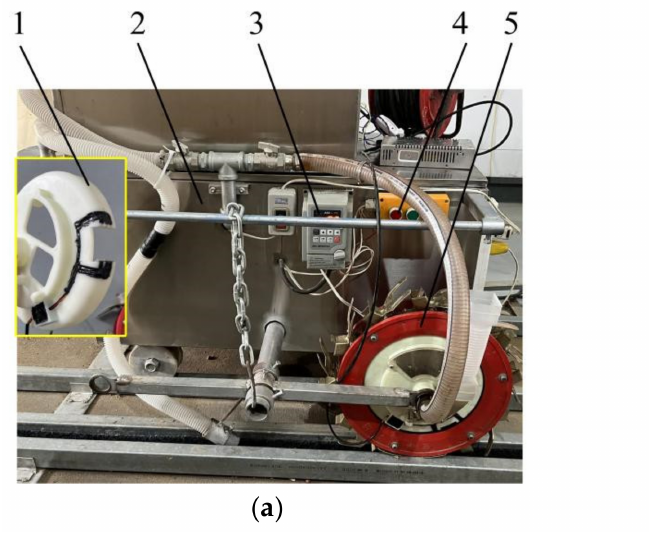
Figure 6. ( a ) Seeding bench test: (1) infrared sensors; (2) pressure-supply device; (3) controller; (4) switch; (5) dibbler; ( b ) diagram of seeding